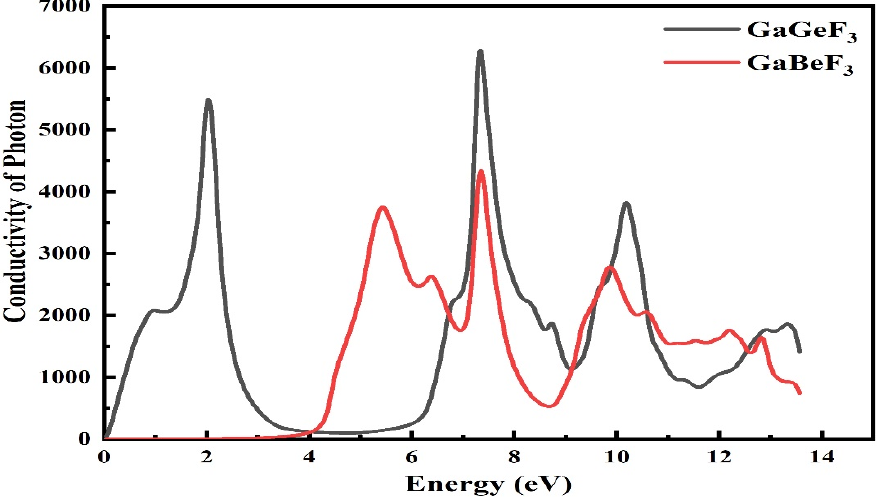
Figure 9. The computed conduction of incident light, represented by the σ ( ω ) of the GaMF 3 (M = Ge and Be) compound.